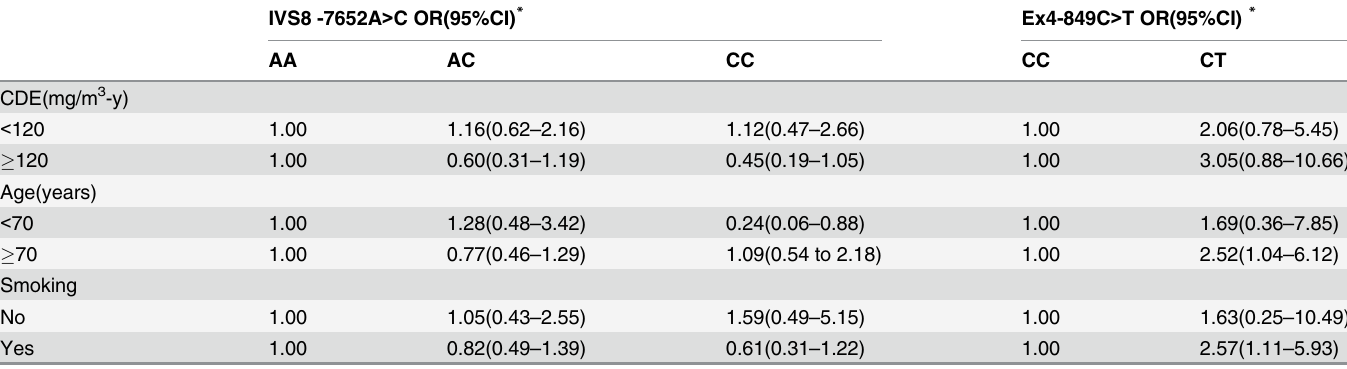
Table 4. Stratification analysis for associations between genotypes of Nalp3 and the risk of silicosis.